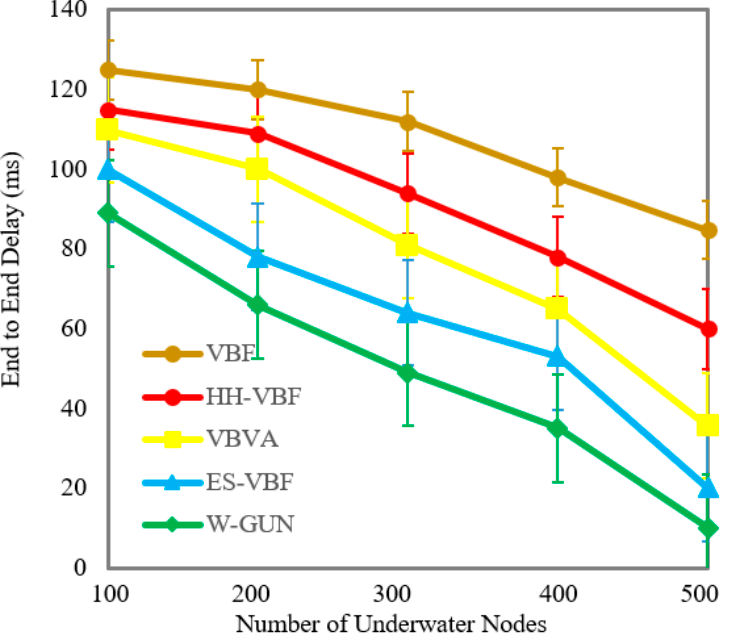
Figure 3. End-to-end delay versus the number of underwater